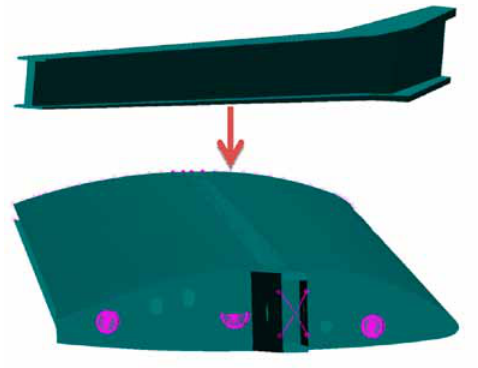
Fig. 2. Geometrical evolution: from an I-beam to a